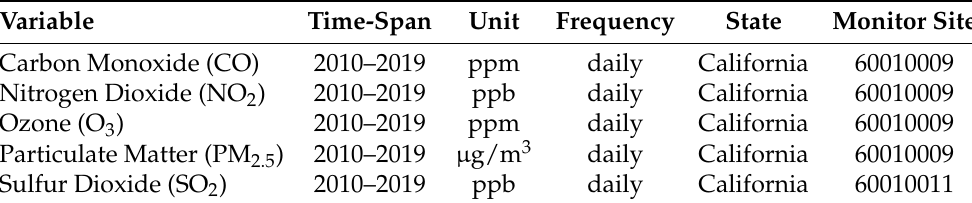
Table 2. Variables.